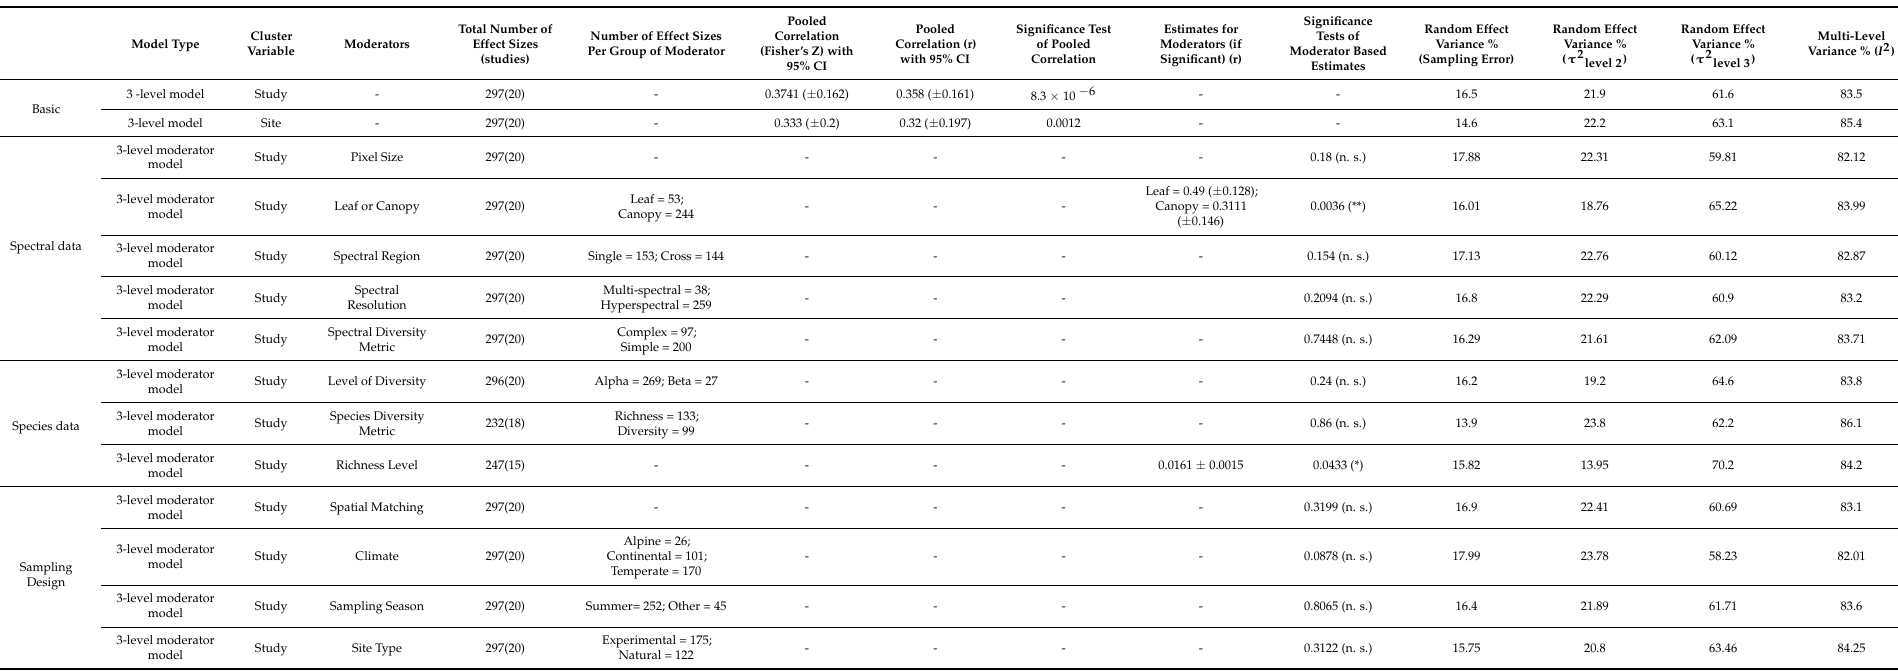
Table 2. Results of the three-level models with and without moderators. Significance levels of estimates are given as n.s. = p > 0.05, * = p ≤ 0.05, ** = p ≤